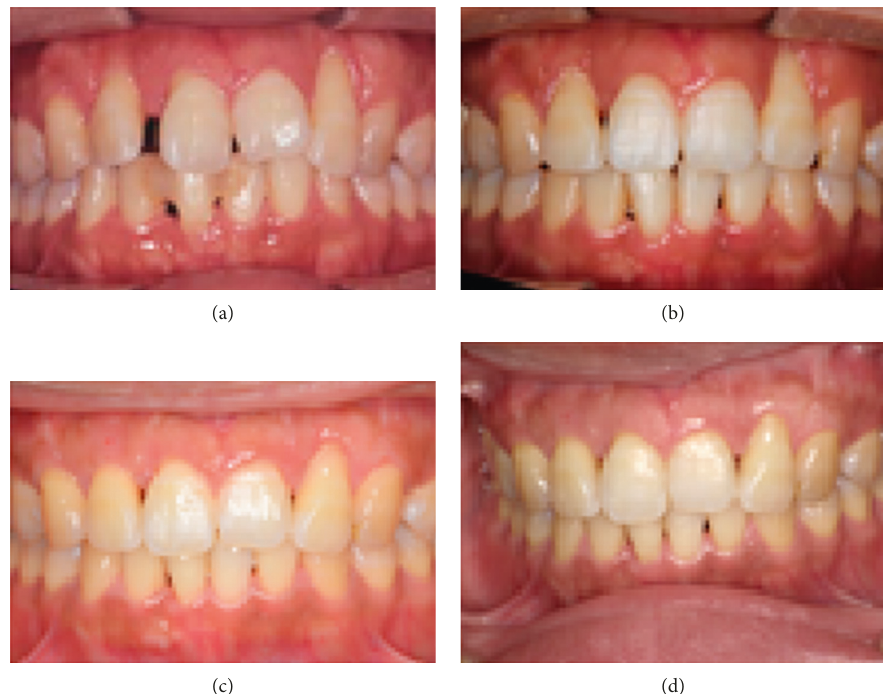
Figure 12: Frontal views of intraoral photographs are shown. (a) Before orthodontic treatment, (b) after orthodontic treatment, (c) at 6 months after periodontal surgical treatment, and (d) at 1 year 5 months after periodontal surgical